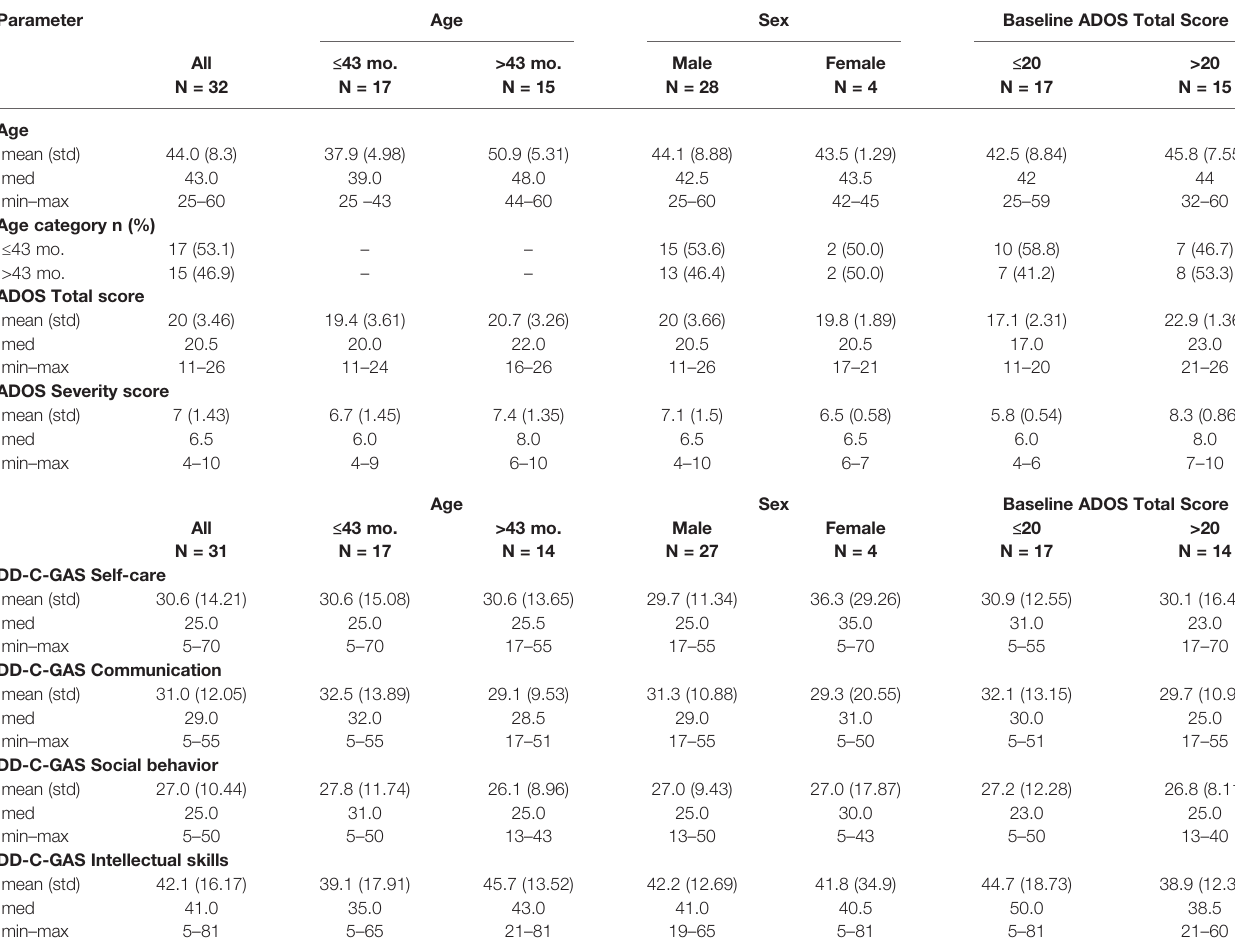
TABLE 2 | Summary statistics of background and demographic data for all participants and by subgroups. Parameter Baseline ADOS Total Score